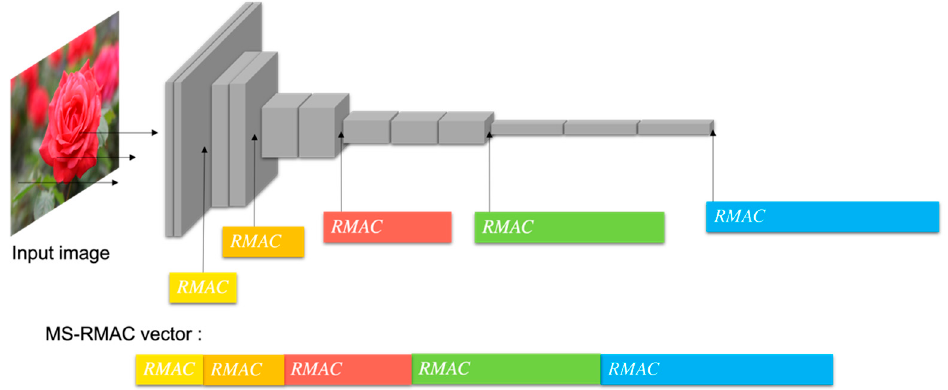
Figure 6. Illustration of MS-RMAC method on VGG 16 architecture.